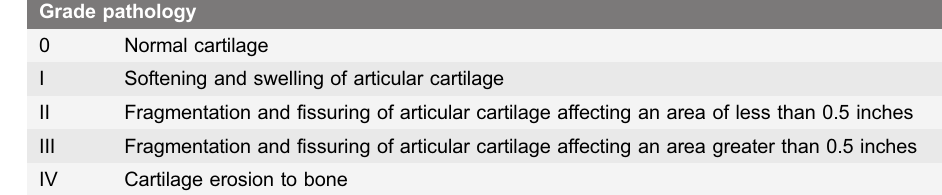
Table 1. Outerbridge